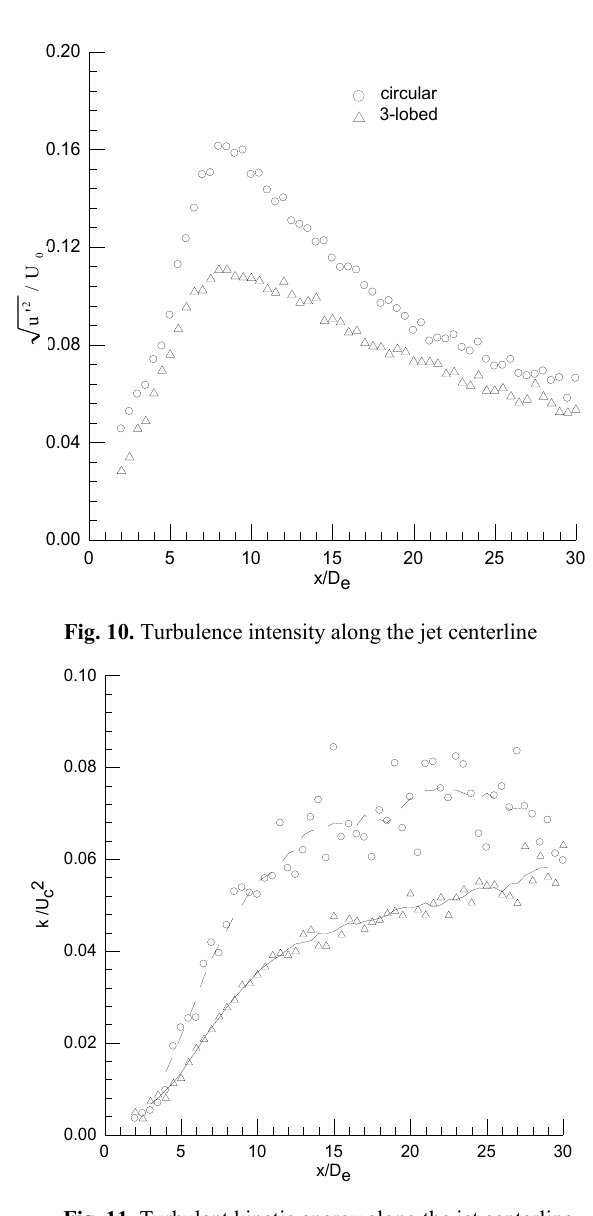
Fig. 11. Turbulent kinetic energy along the jet centerline